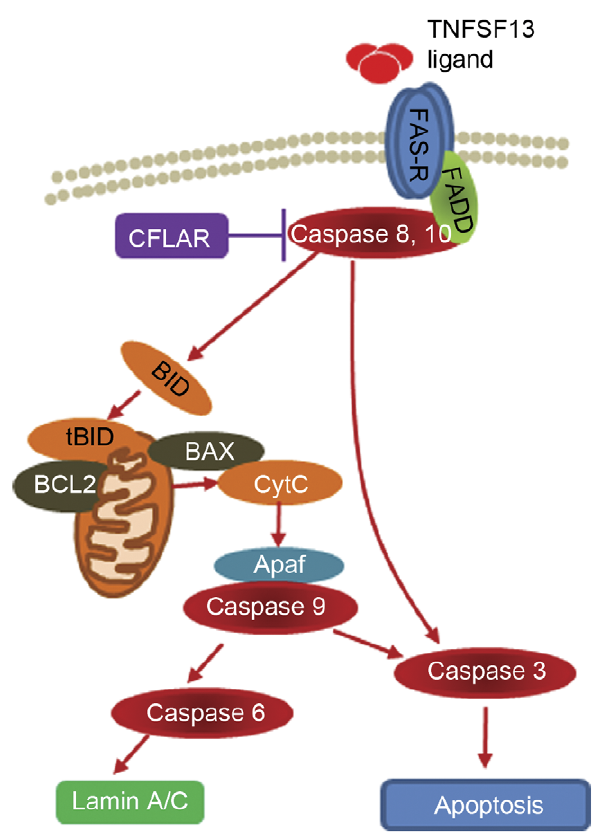
Figure 1. FAS receptor pathway in peripheral cells [ 76 ] . The membrane FAS-R (blue) forms a trimer upon ligand binding (TNFSF13, red). The adaptor molecule FADD (green) then binds to the death domain of FAS-R through its own death domain. The amino terminus of FADD facilitates binding to caspase-8 (maroon oval). Caspase-8 self- activates through proteolytic cleavage into active caspase subunits, which can cleave other effector caspases (3, 6, 9), eventually leading to DNA degradation, membrane blebbing, and other hallmarks of apoptosis. In most cell types (Type II), caspase-8 catalyzes the cleavage of the pro-apoptotic BH3-only protein BID (orange) into its truncated form, tBID. tBID engages anti-apoptotic members of the family (e.g. BCL-2), allowing pro-apoptotic members (e.g. BAX) to translocate to the outer mitochondrial membrane, thus permeabilizing the membrane and facilitating release of pro-apoptotic proteins such as cytochrome c (tan). Cytochrome c release reinforces the cellular apoptotic drive through the intrinsic apoptotic pathway. Death receptors 4/5 (TNFSF10) appear to have identical intracellular pathway signaling to FAS receptor